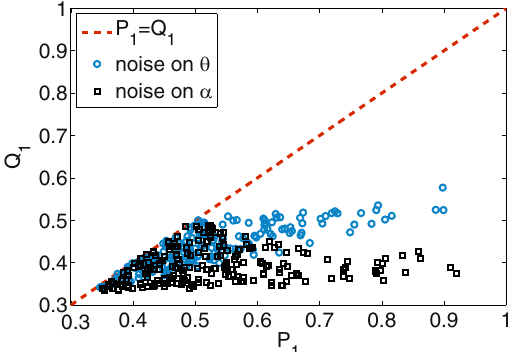
Figure 1. Numerical comparison of the final and initial ground state populations Q 1 vs. P 1 for a three-level system subject to noisy stimulated adiabatic passage. Considered are randomly generated initial states, noise distributions λ k ’s, and classical noise affecting the parameter θ (circles, with α fixed as α = cos 1/3 ) and α (squares, with θ fixed as θ = cos 7/10